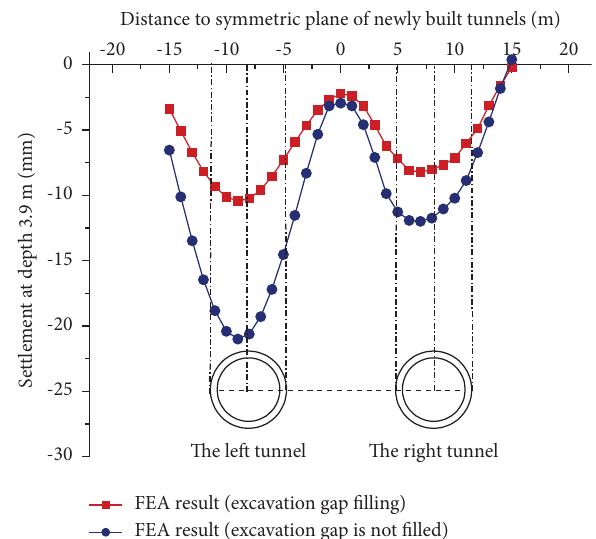
Figure 16: 3.9m depth simulation